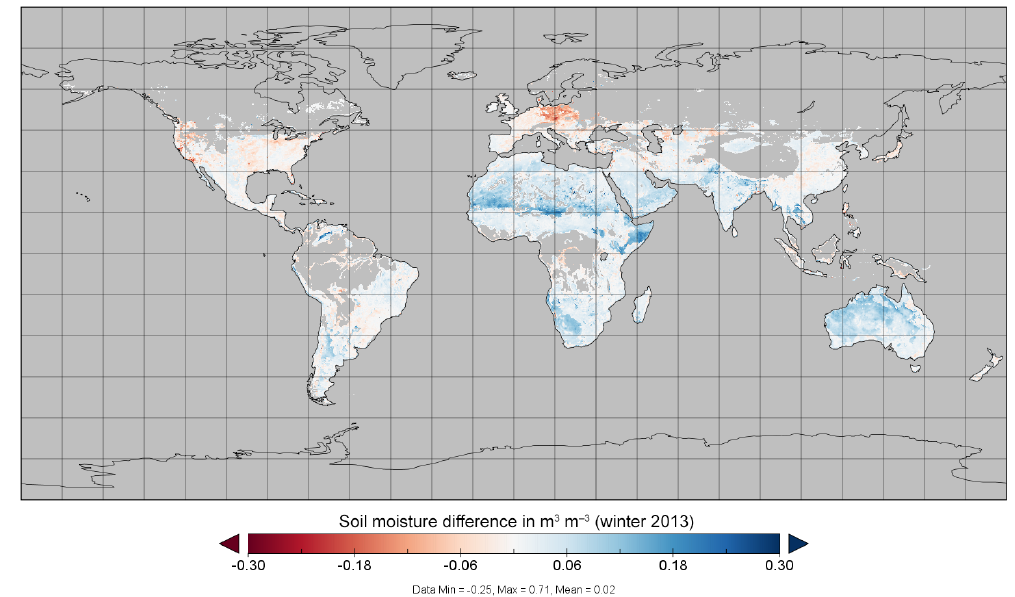
Figure B2. Absolute differences in soil moisture (ESA CCI SM minus CCI NRT) for winter 2013.